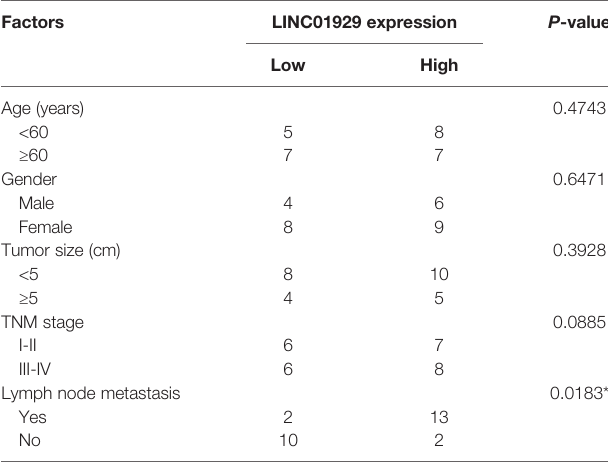
TABLE 2 | Correlation between LINC01929 expression and clinicopathological factors in patients of OSCC.